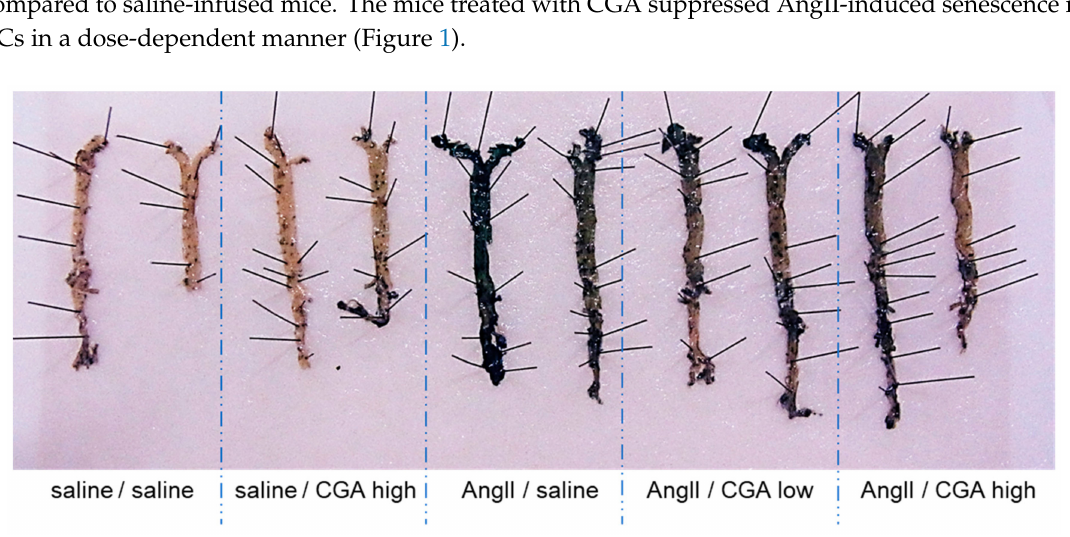
Figure 1. E ff ects of CGA on vascular senescence. SA- β -gal staining of aorta with or without CGA, low (20 mg / kg / day) or high (40 mg / kg / day), on 14 day after AngII infusion are